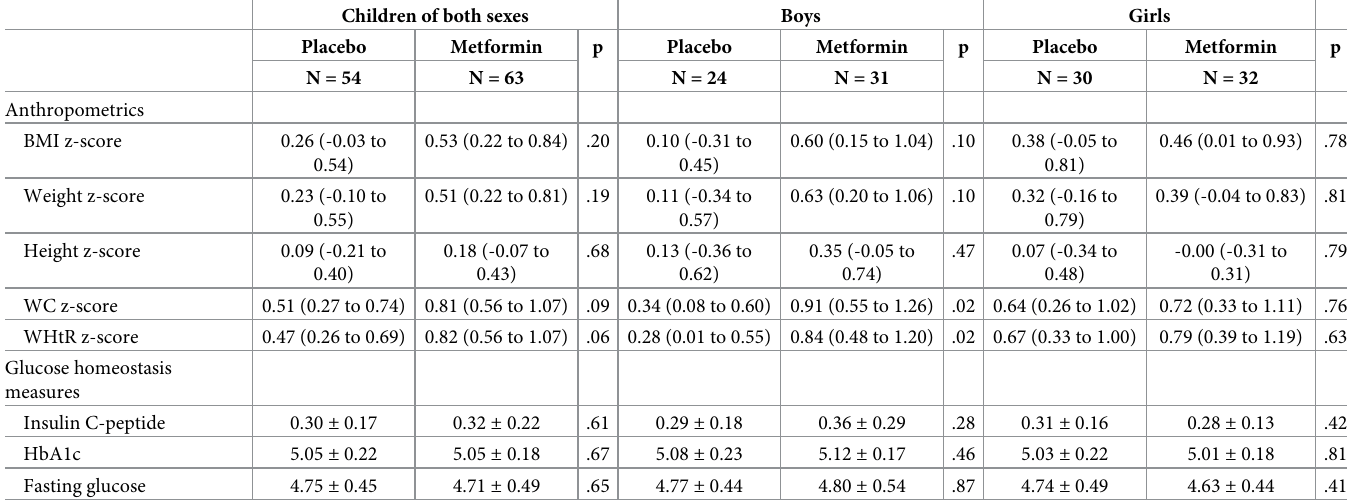
Table 3. Anthropometrics and measures of glucose homeostasis, all children (n = 122) at inclusion, and according to